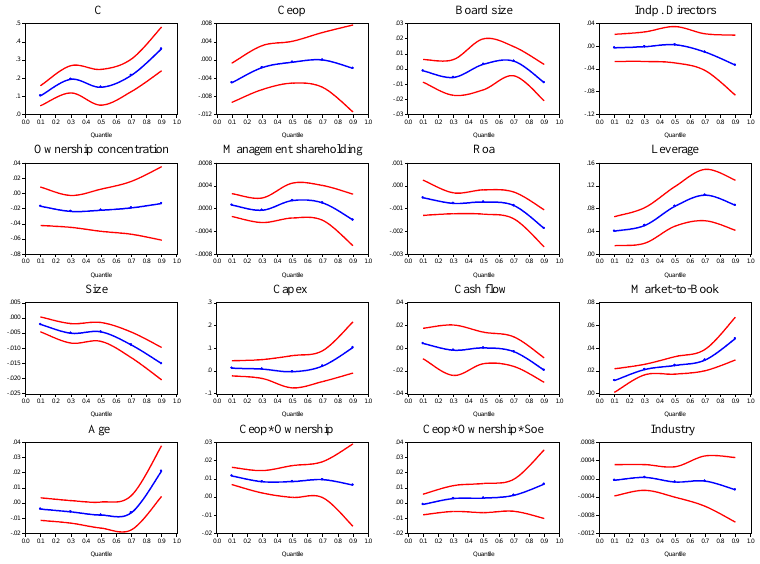
Figure 2. coefficient change of the parameters related to model 2 in various